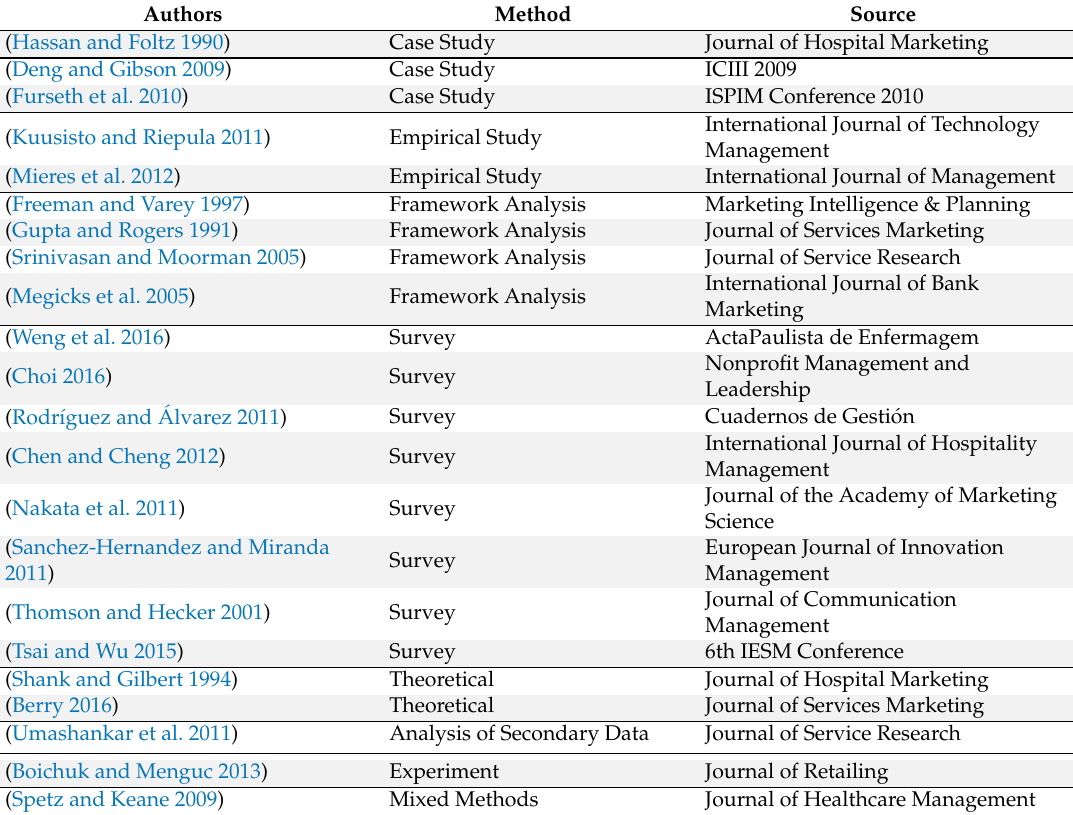
Table 4. Identifying the methods from selected